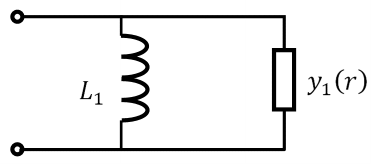
Figure 8. A simplified equivalent circuit for TE nm mode.